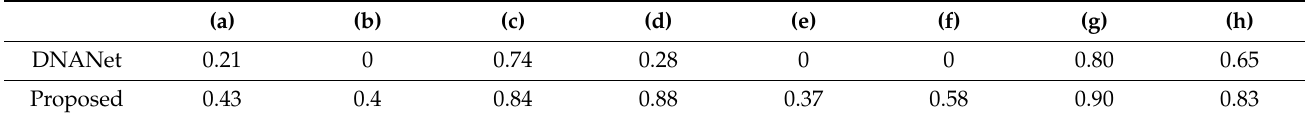
Table 4. Comparison of mIoU for the proposed method with that of